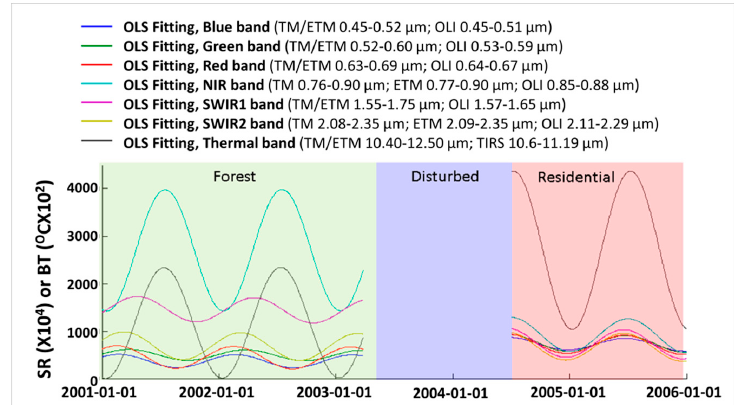
Figure 1. Example of time series models estimated for all Landsat bands for Forest and Developed (residential) land cover classes. During the transition between classes, where Continuous Change Detection and Classification (CCDC) did not fit a model, land cover was labeled “Disturbed”. BT = brightness temperature; ETM = Enhanced Thematic Mapper Plus; NIR = near-infrared; OLS = ordinary least squares; SR = surface reflectance; SWIR1 = shortwave infrared 1; SWIR2 = shortwave infrared 2; TIRS = Thermal Infrared Sensor; TM = Thematic Mapper.